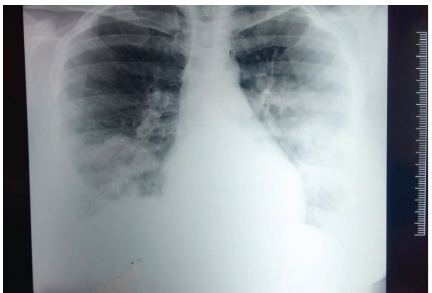
Figure 1: Chest X-ray showing bilateral interstitial infiltrates.